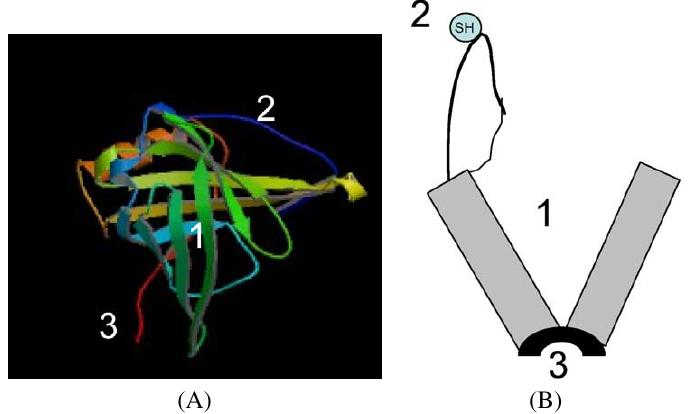
Fig. 2. (A) Ribbon model [66] of the ApoD molecule with the three main structure/functional features (1, 2, and 3 in the figure): 1 – The bands in green (4 bands), blue (2 bands), and yellow (2 bands) form the anti-parallel β -barrel structure of the ligand-binding cup where hydrophobic molecules are bound. 2 – Ω -loop containing cysteine-rich residues with one free hydrogen–sulphur group (SH) that may bind to other molecules with cysteine residues and form dimers and trimers and complexes with other molecules. 3 – N-terminal 3 10 - α -helix found in proteins associated with endosomal trafficking serving as a docking device on intracellular membranes. (B) Cartoon model of ApoD with the same three main features as shown in